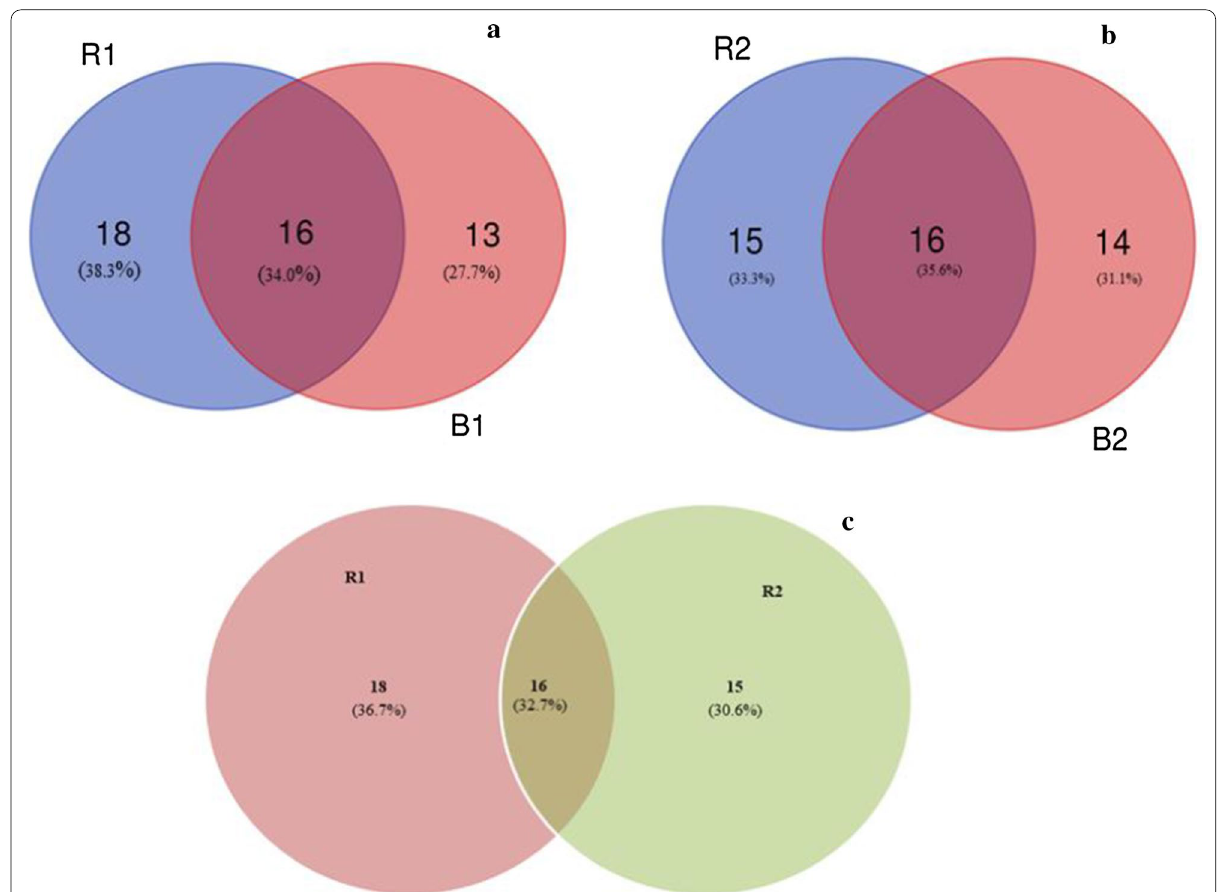
Fig. 1 Venn diagram of shared operation taxonomic units between the bacterial components (at the order level) of sunflower rhizosphere and bulk soils obtained from Ditsobottla and Kraaipan farms. R1 Ditsobottla rhizosphere soil; B1 Ditsobottla bulk soil; R2 Kraaipan rhizosphere soil; B2 - Kraaipan bulk soil